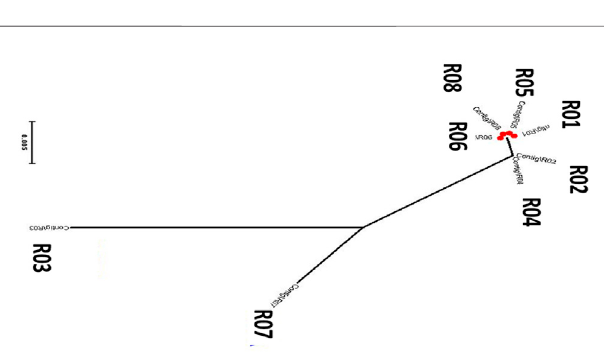
FIGURE 3 | Phylogenetic tree of eight different Magnaporthe species isolated from different hosts in Yunnan Province of China. The sequences were derived from the PCR ampli fi ed products with ITS1 and ITS4